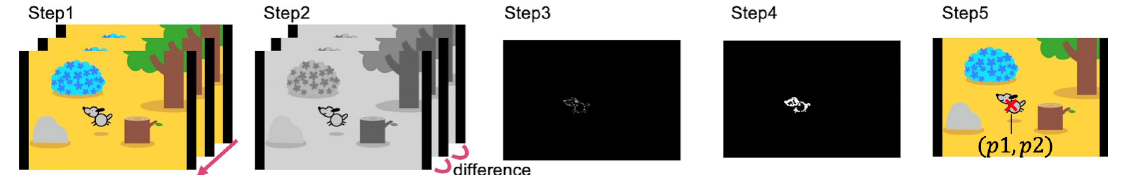
Fig 3. How to find the motion object’s positions. Step 1: Used three consecutive frames. Step 2: Gray scaled these frames. Step 3: Calculated the difference between the previous frame and the current frame and between the current frame and the next frame. Then, these two differences were multiplied together. Step 4: Performed noise reduction by dilation processing and detected connected objects. Step 5: Calculated the center of gravity from an object. This center was defined as the moving object’s